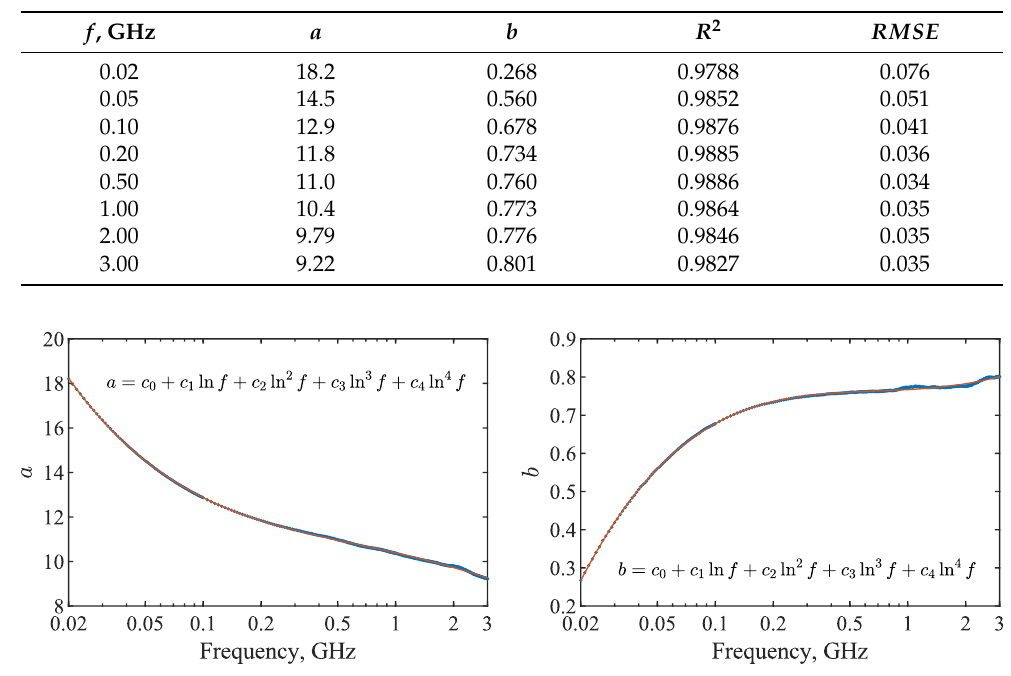
Table 1. Slope a , intercept b , coefficient of determination R 2 and root-mean-squared error RMSE of √ ε (cid:48) ( θ ) relations at given frequencies f . fitting Equation (2), which modeled